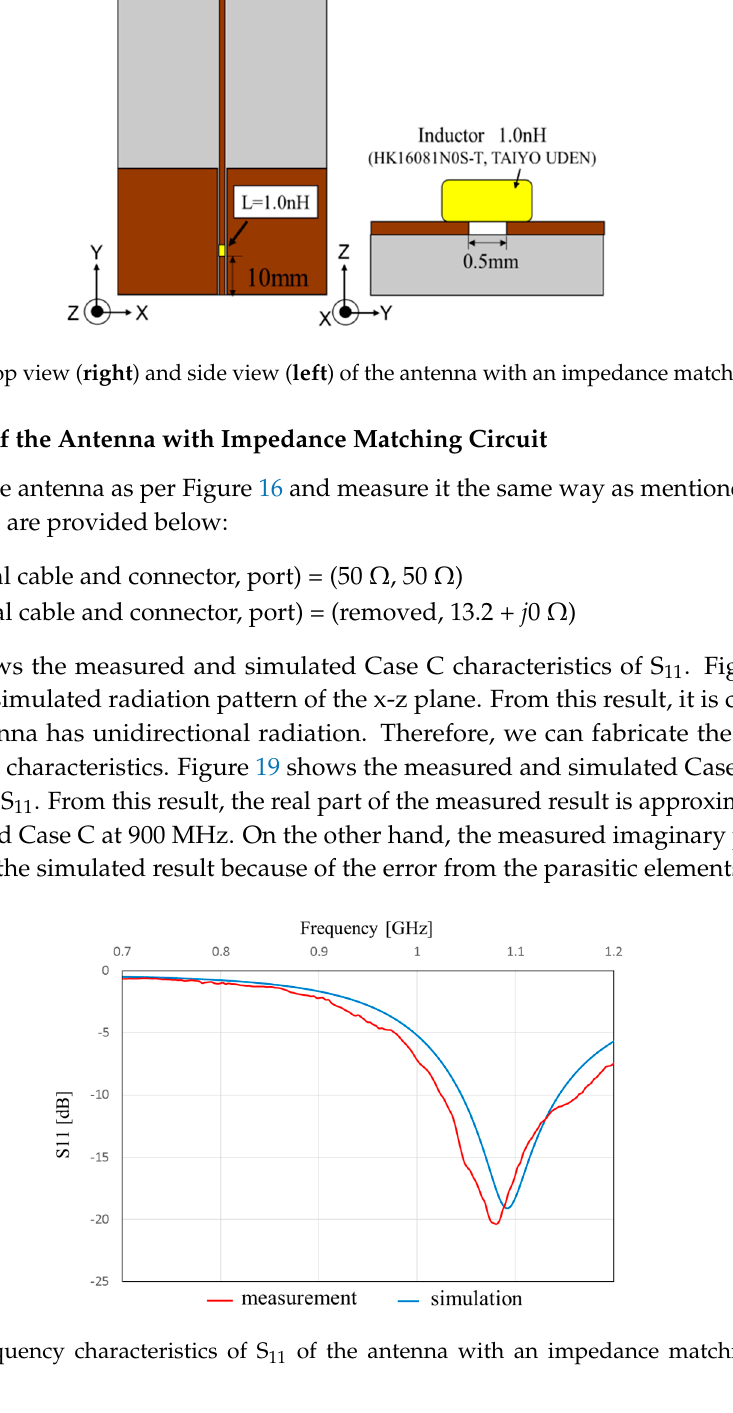
Figure 17. Frequency characteristics of S 11 of the antenna with an impedance matching circuit (Figure 16).